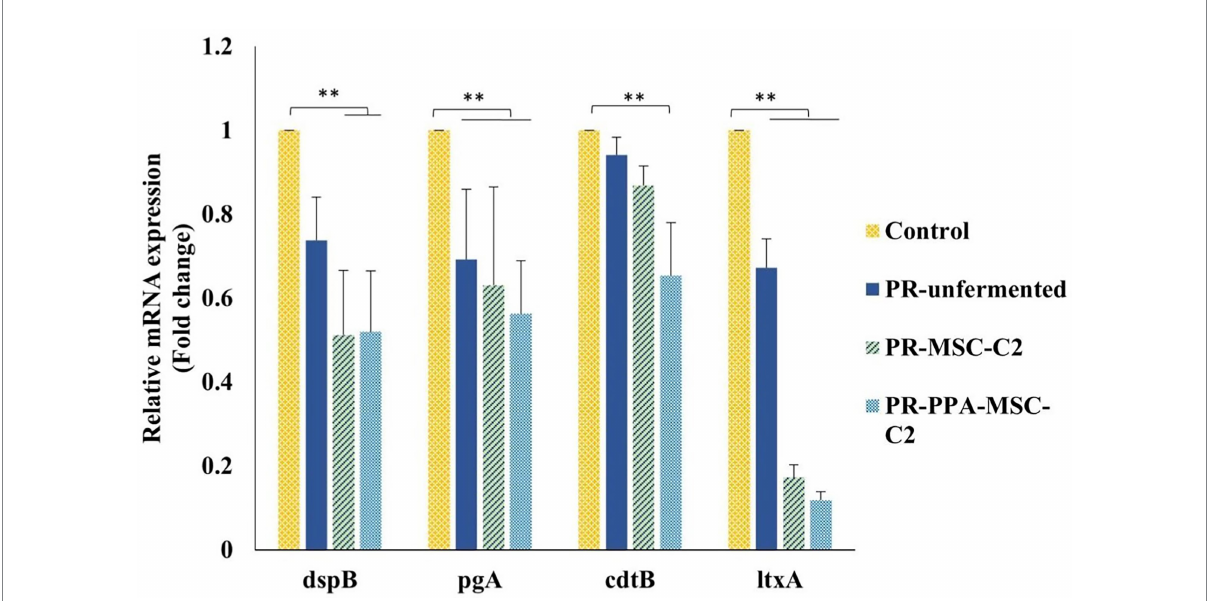
FIGURE 5 Effects of PLA-containing LAB-PR extract against A. actinomycetemcomitans gene expressions. Control, PR-unfermented, PR-MS-C2, and PR- PPA-MSC-C2 represent the BHI/YE without a test sample, unfermented PR extract, MSC-C2 fermented PR extract, and MSC-C2 fermented PR extract with 1 mg/ml PPA, respectively. Total mRNA was isolated, cDNA levels were determined by RT-qPCR, and Ct values were normalized to 16sRNA data. Data are expressed in terms of fold changes relative to the control (BHI/YE media without a test sample). Data represent the mean value from three independent assays in triplicate, and error bars represent the standard deviation (SD). Differences between groups were determined via one-way ANOVA. ** p < 0.05 between the groups represented in the